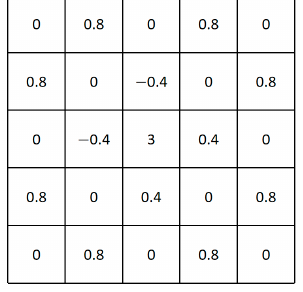
Figure 6. 5 × 5 convolution kernels.